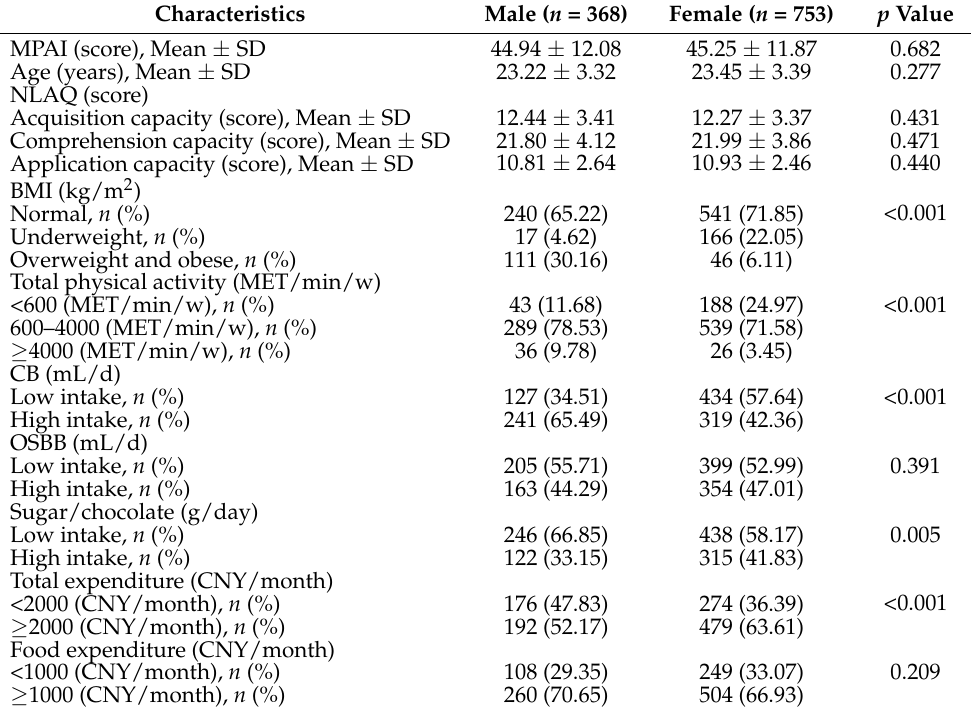
Table 1. The demographic characteristics of total 1121 participants stratified by sex.